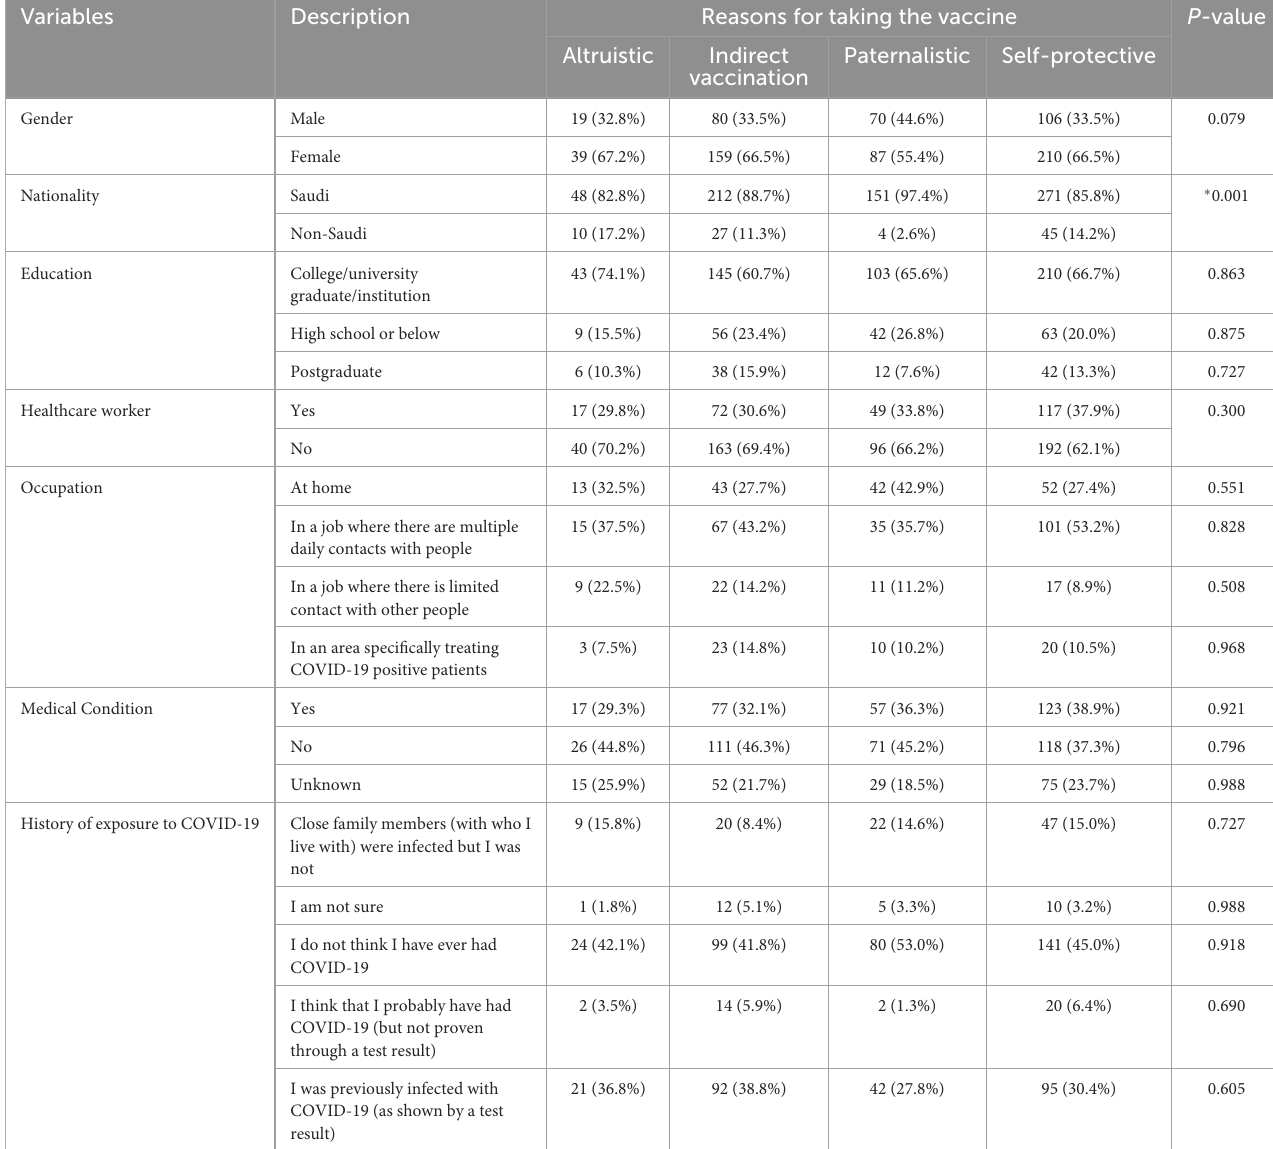
TABLE 4 Relationship between demographic/clinical characteristics and taking the vaccine.